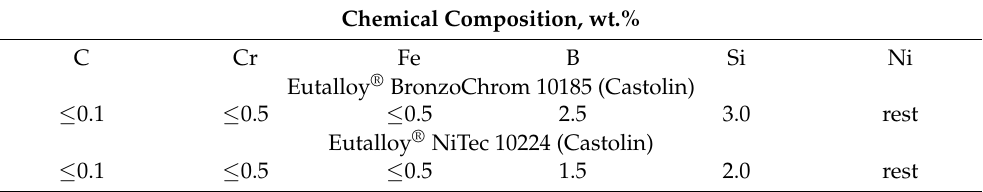
Table 5. Physical properties of the Ni-B-Si metal deposit according to the manufacturer’s data. Mechanical Properties of the Coating Metal Deposit (1) Melting range Hardness, HV30 Density, g/cm 3